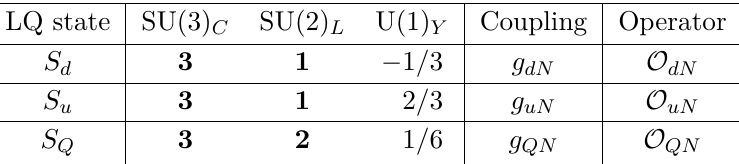
Table 2 . Scalar LQs and the N R pair operators they can generate in N R